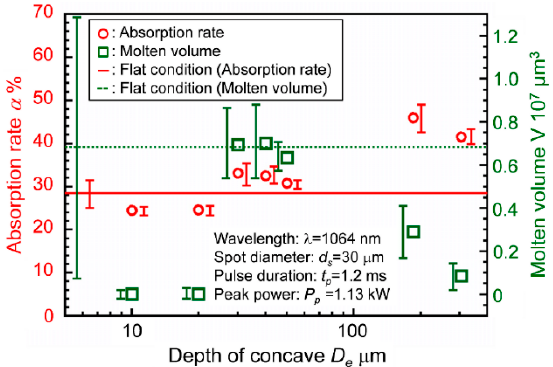
Figure 8. Variations of light absorption and molten volume for different concave depths under transitional processing condition between heat conduction and keyhole welding modes.